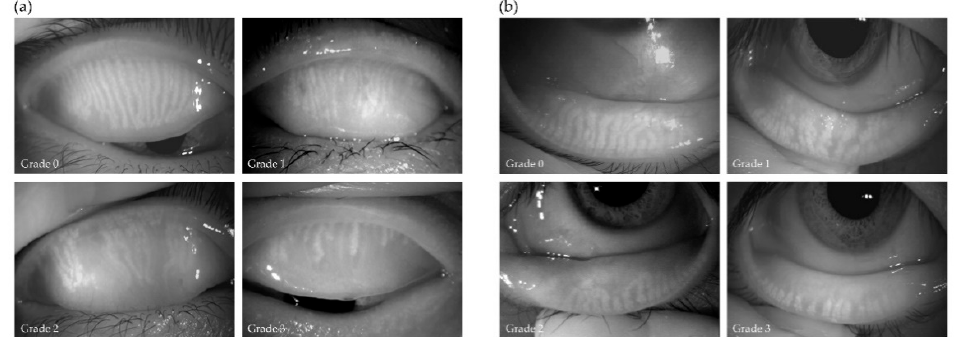
Figure 1. Representative images obtained by noncontact meibography from upper ( a ) and lower ( b ) eyelids with a meiboscore of 0 to 3. The lost area of meibomian glands was graded as 0 for no loss (upper left panels), 1 for a lost area of less than one-third (upper right panels), 2 for a lost area of between one-third and two-thirds (lower left panels), or 3 for a lost area of more than two-thirds (lower right panels).